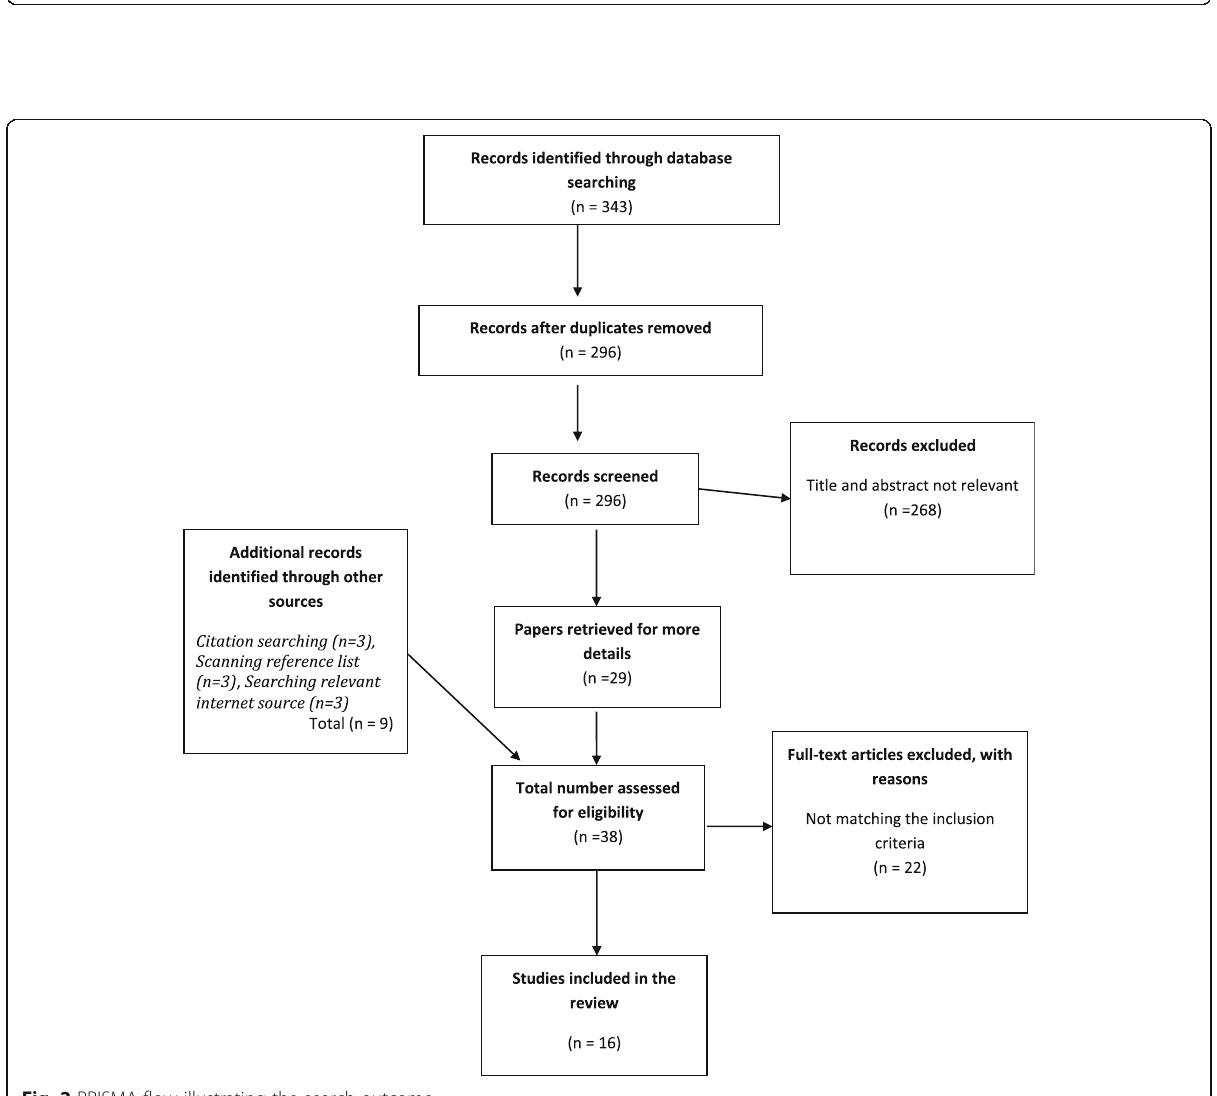
Fig. 2 PRISMA flow illustrating the search